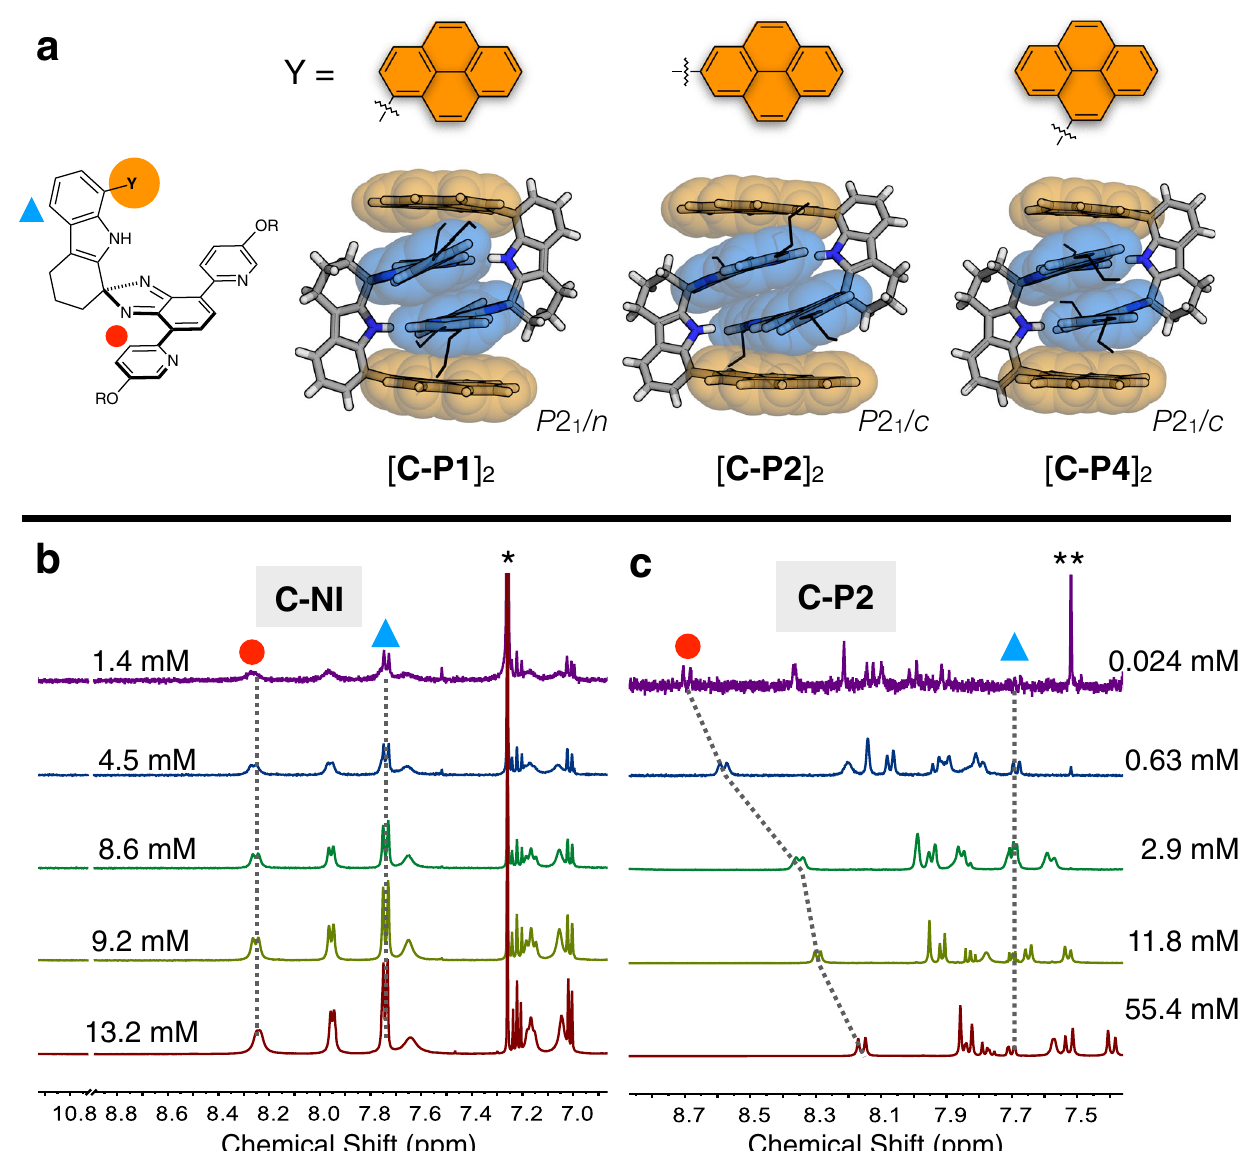
Fig. 6 X-ray structures of regioisomeric dimers and structure-dependent monomer – dimer equilibrium. a Capped-stick representation of the X-ray structures of [ C-P n ] 2 ( n = 1, 2, and 4). Partial 1 H NMR (400 MHz, T = 298 K) spectra of b C-NI and c C-P2 were obtained by varying the concentration of CDCl 3 solution samples. Proton resonances are labeled with the symbols denoted in the chemical structure shown in a . The symbols * and ** denote residual solvent and satellite peaks, respectively. NMR nuclear magnetic